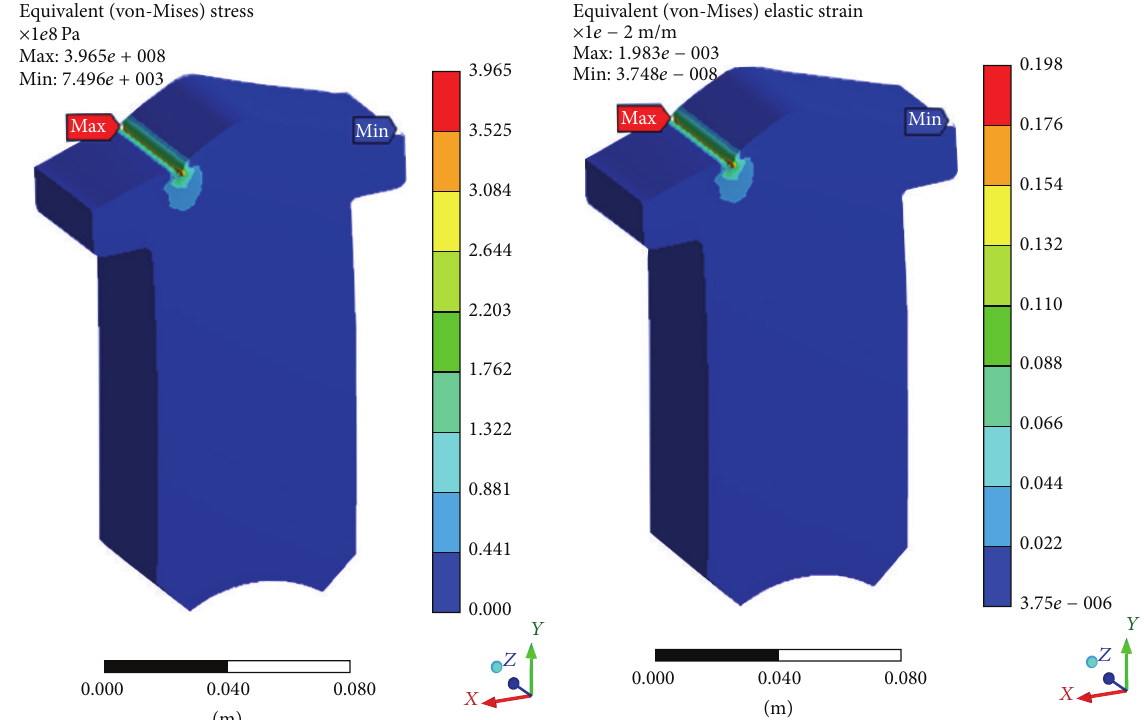
Figure 9: Equivalent stress and equivalent strain cloud of the cropping hammer.